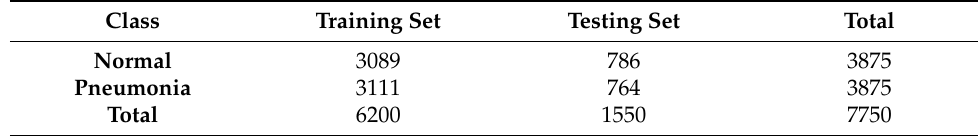
Table 2. Number of samples for train and test